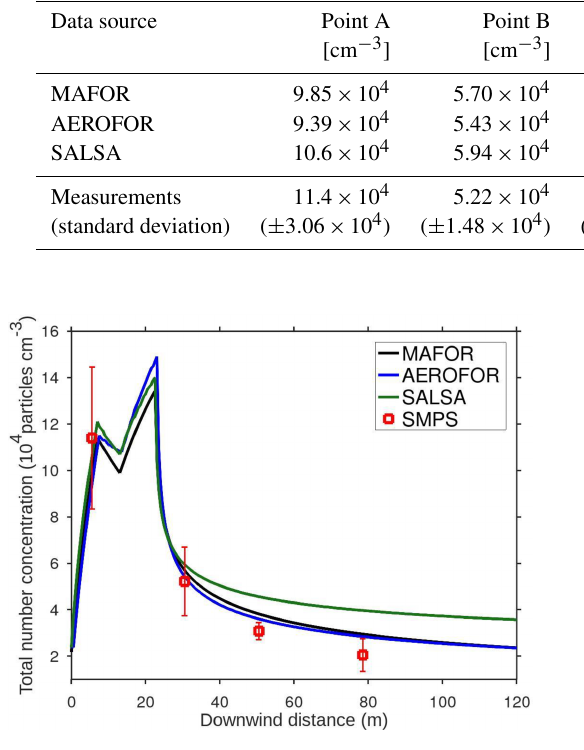
Figure 10. Comparison of total particle number concentrations as a function of downwind distance in the Urban Case scenario. Model results from the aerosol dynamics models MAFOR, AEROFOR, and SALSA. Measurement data from SMPS at points A, B, C, and D (error bars indicate 1 σ standard